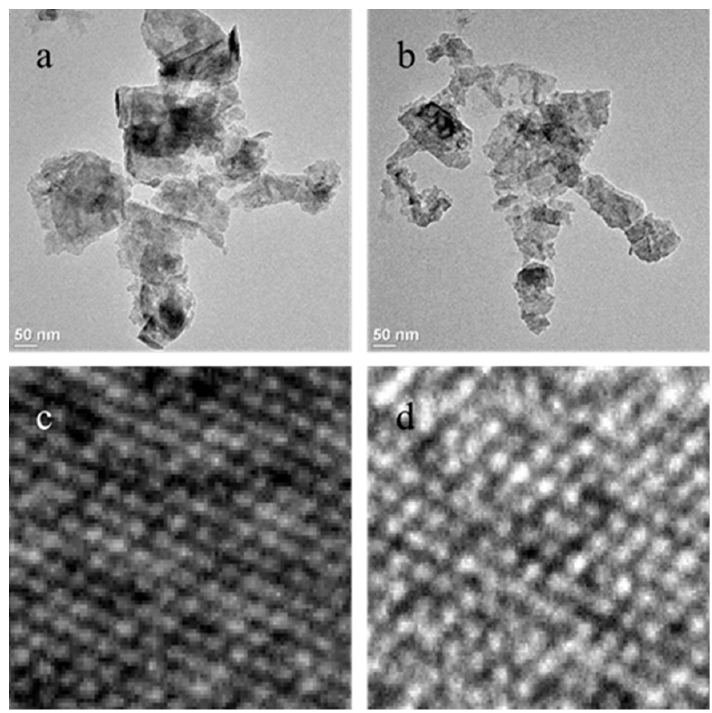
Figure 1. Transmission electron microscope (TEM) images of MoS 2 nanosheets. ( a , c ) Low- and high-resolution images of MoS 2 -ethanethiol; ( b , d ) low- and high-resolution images of MoS 2 -nonanethiol.